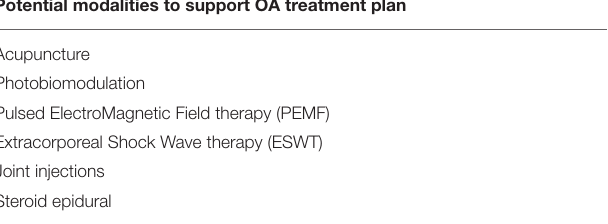
TABLE 6 | Potential modalities discussed in this paper that may be added to an OA treatment plan to support the individual